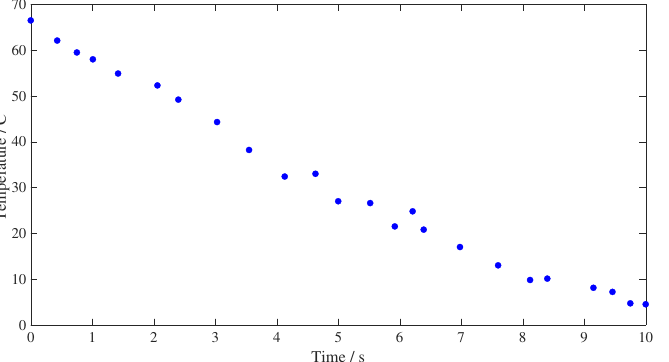
Figure 3. Set of points corresponding to the temperature of the sample after its submersion in liquid nitrogen for different amounts of time, from 0 to 10